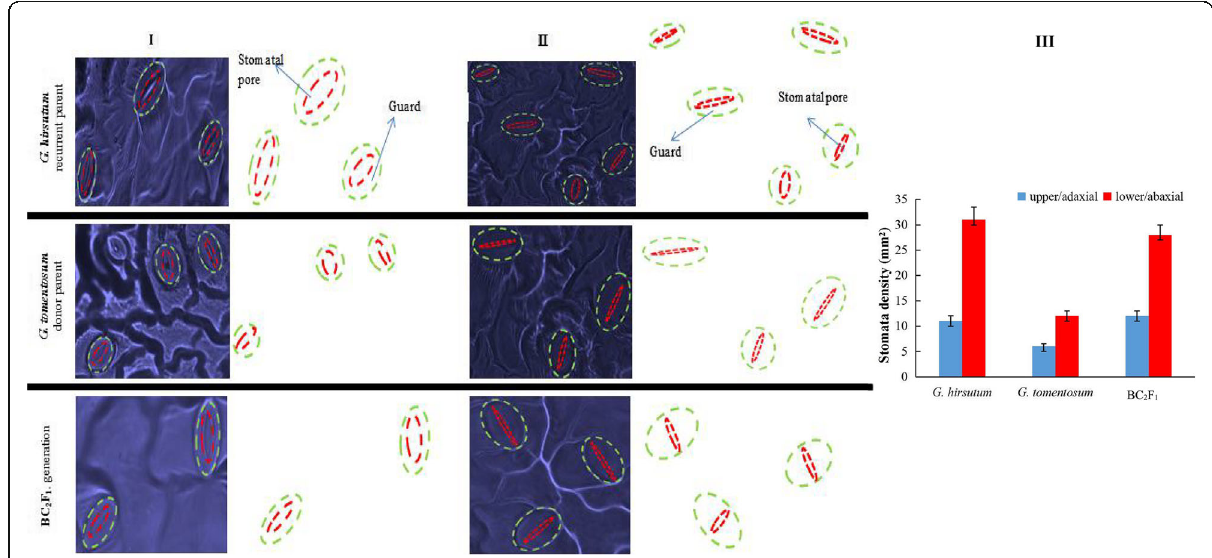
Fig. 1 Microscopic examination of stomatal structure, pore size and stomatal density on the adaxial and axial regions of the leaf surface. The structures of stomata were observed under light microscope with magnification of X40 while the density determination was observed at X20. I: observation at 0 h of stress exposure; II: 24 h of stress exposure and III: stomatal